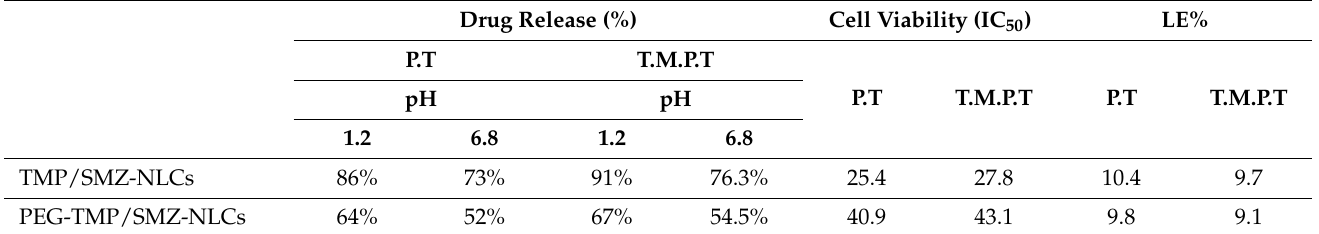
Table 3. Drug release, cell toxicity, and LE% for TMP/SMZ-NLCs and PEG-TMP/SMZ-NLCs at the preparation time and 3 months after preparation.